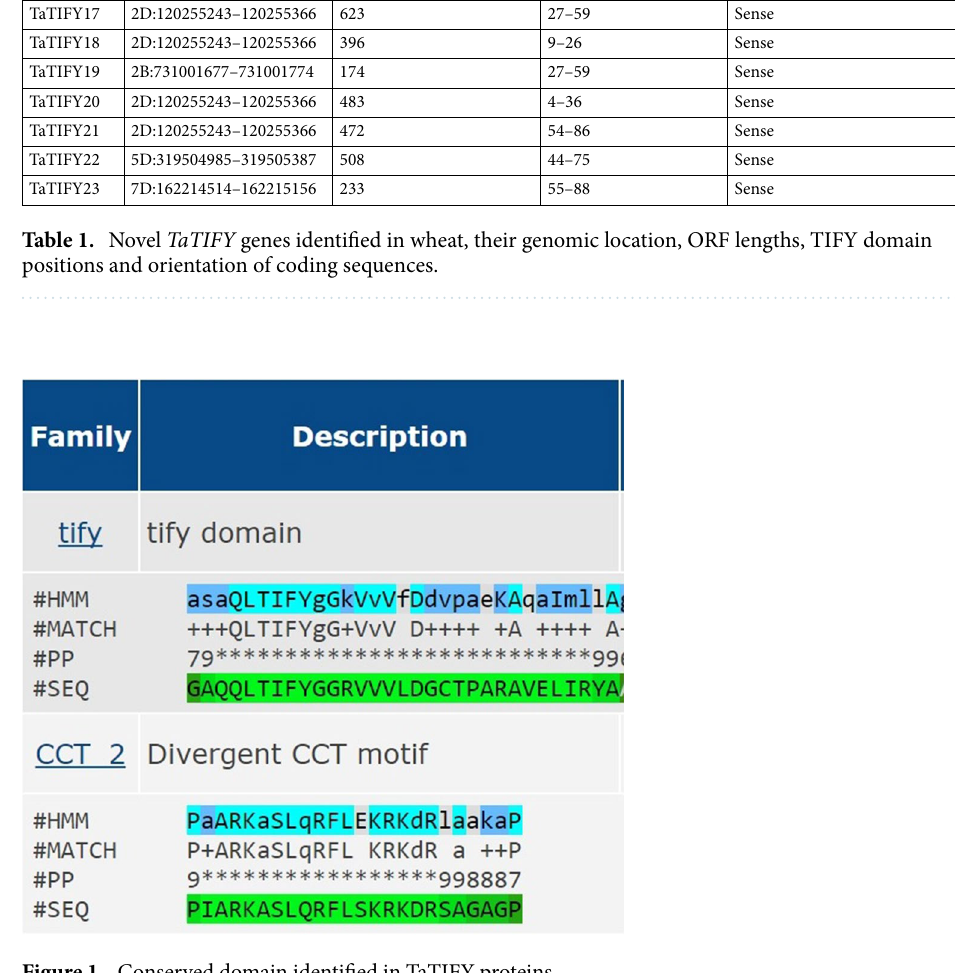
Figure 1. Conserved domain identified in TaTIFY